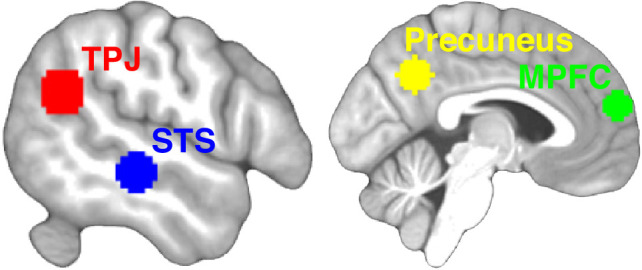
Regions of interest (ROIs).Six ROIs were defined based on peaks reported in an activation likelihood estimation meta-analysis of 16 fMRI studies involving theory-of-mind reasoning (van Veluw and Chance, 2014). The ROIs consisted of 10-mm-radius spheres centered on peaks in the bilateral temporoparietal junction (TPJ) and superior temporal sulcus (STS), and two midline structures: the precuneus and medial prefrontal cortex (MPFC). Here, the TPJ and STS ROIs on the left side are shown.